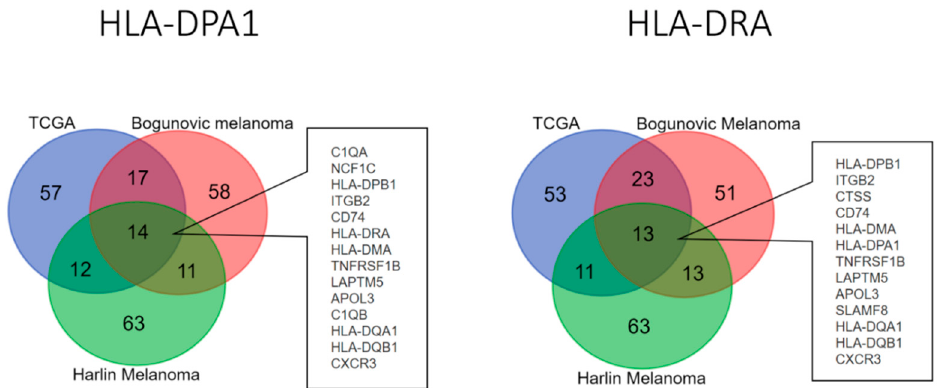
Figure 5. HLA class II expression pattern in cutaneous melanoma. The expression pattern of 15 HLA class II genes in primary cutaneous melanoma tumor and tumor cell lines was displayed as heatmap in log ratio of mean centered expression level. The expression pattern was observed to be more diverse in skin cutaneous melanoma cell lines than in primary tumor samples (especially expression of HLA-DMA , - DMB , - DPA1 , - DPB1 , - DQA1 , - DQB1 , - DRA and - DRB1 ) . The dataset was composed of 43 primary tumors of cutaneous melanoma and 164 cell lines of cutaneous melanoma.